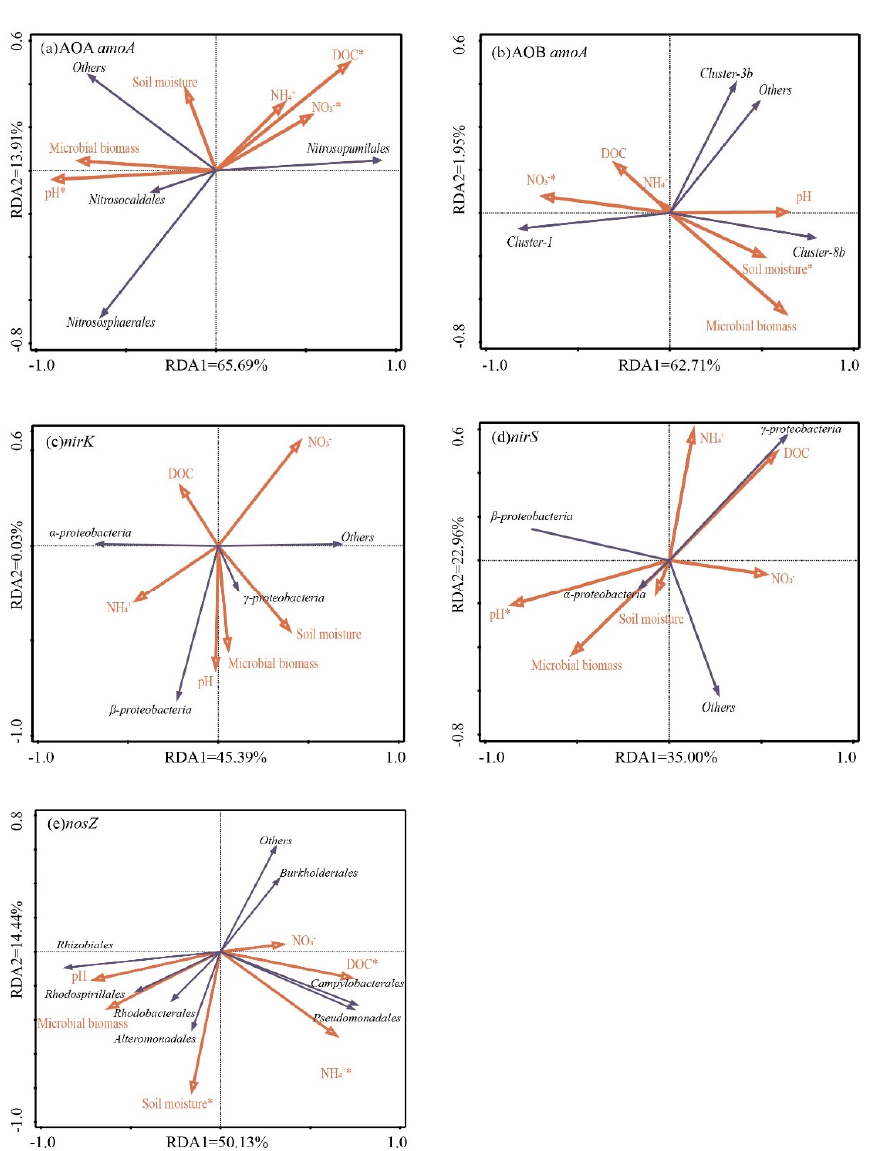
Figure 5. Redundancy analysis (RDA) showing the correlations between nitrifiers (AOA amoA ( a ), AOB amoA ( b )) and denitrifiers ( nirK ( c ), nirS ( d ) and nosZ ( e )) bacterial communities and the soil physico-chemical properties. * Significant at the 0.05 probability level. SM is the soil moisture. DOC is dissolved organic carbon. MB is microbial biomass.